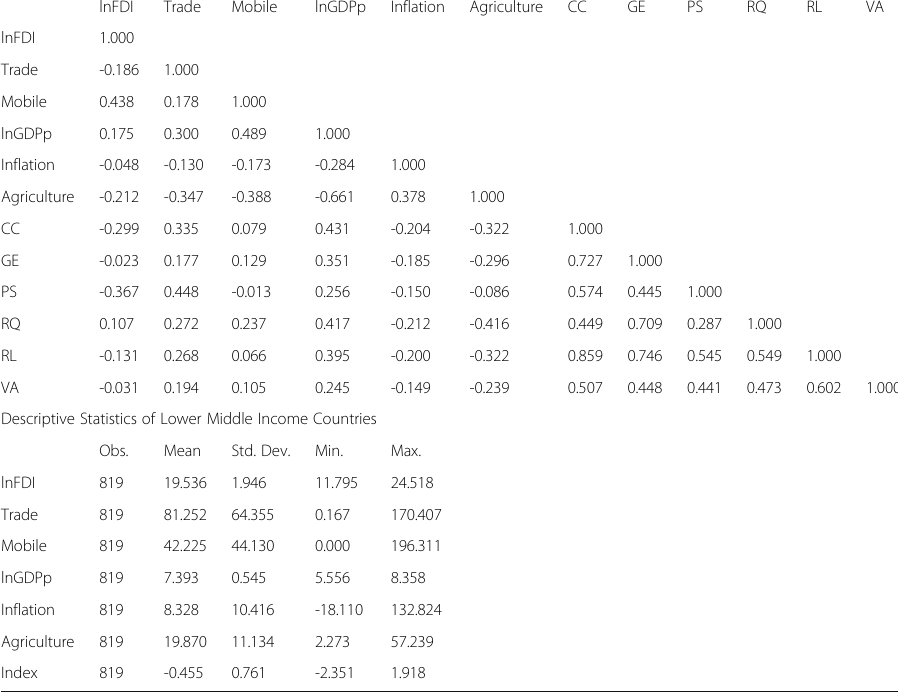
Table 4 Correlation Matrix of Lower middle income